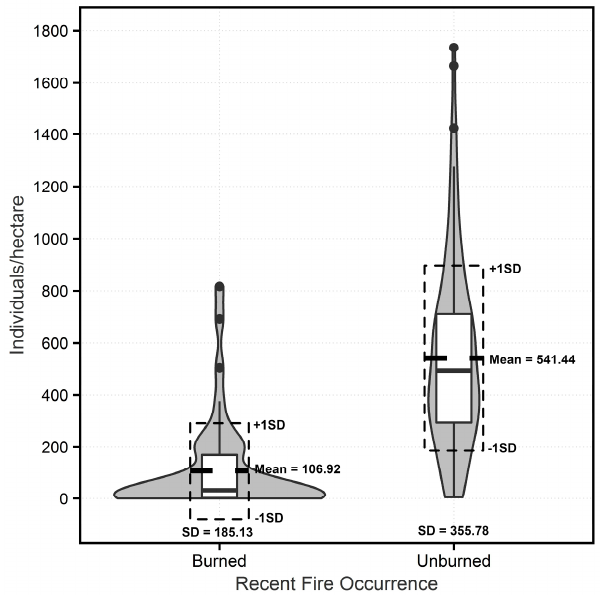
Figure 2. Measured density (individuals/ha) in forest stands burned in 2011 and 2013 vs. unburned stands in the Southwest Jemez Mountains, New Mexico, USA. Tuckey Honest Significant Difference (HSD) showed significant difference in the mean densities. Wider shaded areas represent a higher number of points. SD, standard deviation.